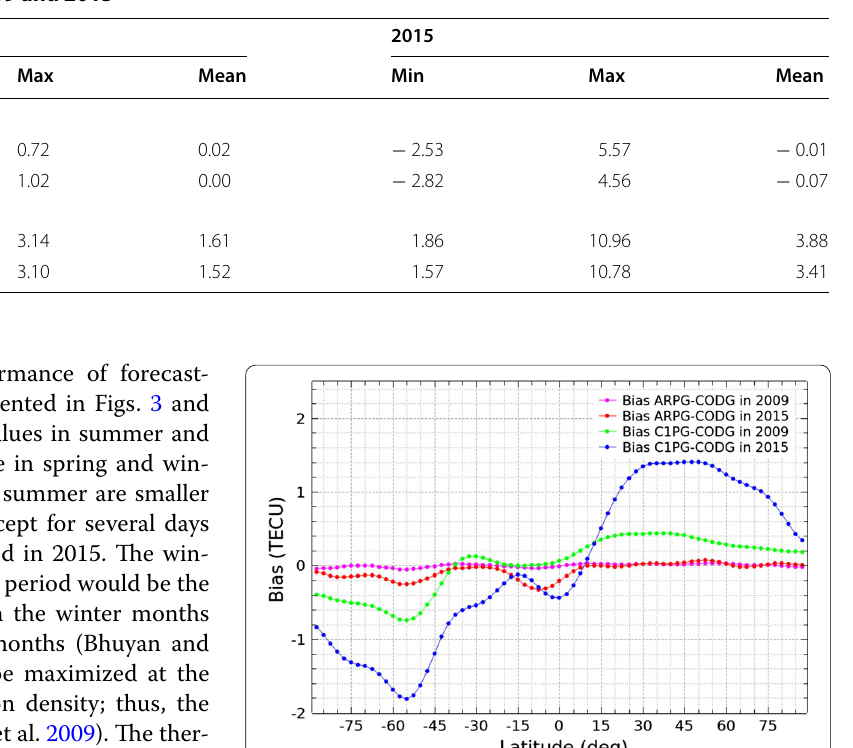
Table 1 Minimum, maximum, and mean values of bias and RMS values of the differences between forecasting VTEC val-